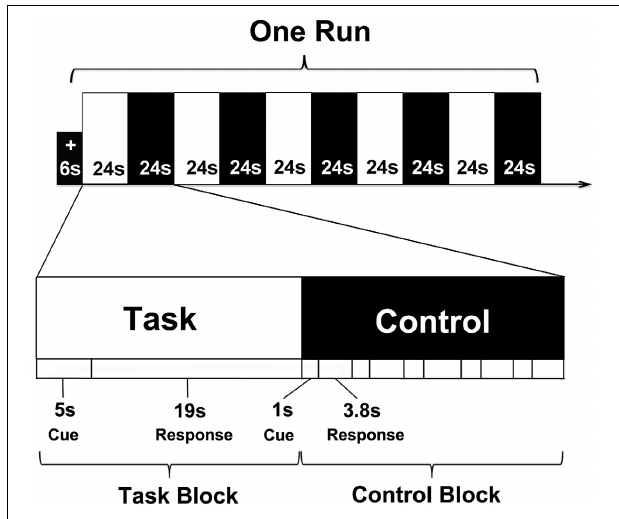
FIGURE 1 | fMRI experimental